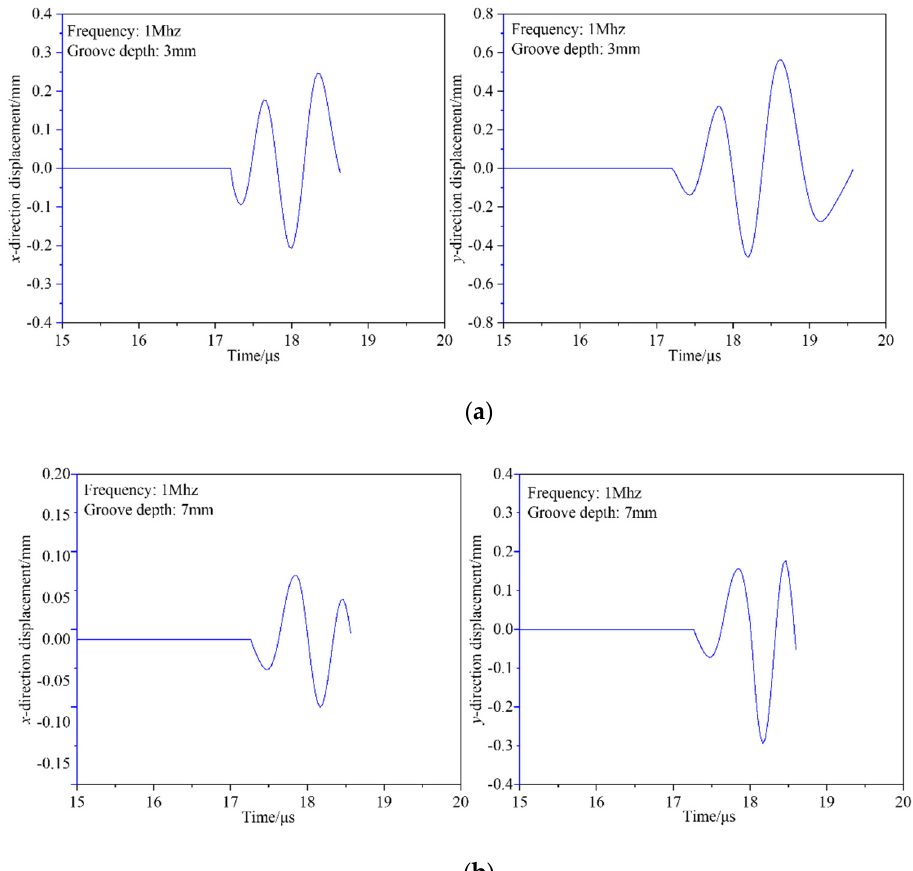
Figure 8. x-direction and y-direction displacement–time curves were acquired with a 1 MHz trans- Figure 8. x -direction and y -direction displacement–time curves were acquired with a 1 MHz trans- ducer for different groove depths: (a) groove depth of 3 mm, x-direction displacement, y-direction ducer for different groove depths: ( a ) groove depth of 3 mm, x -direction displacement, y -direction displacement; ( b ) groove depth of 7 mm, x-direction displacement, y-direction displacement. displacement; ( b ) groove depth of 7 mm, x -direction displacement, y -direction